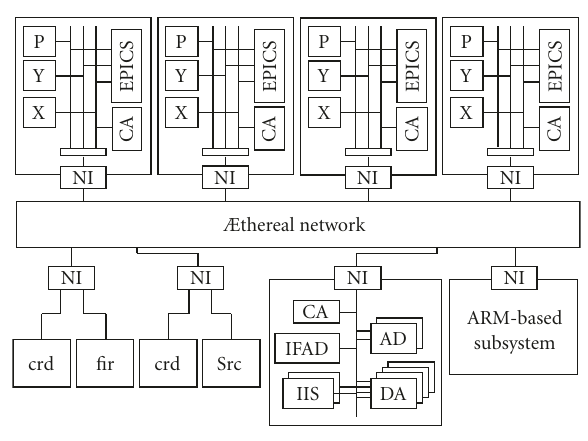
Figure 1: Next-generation car infotainment system